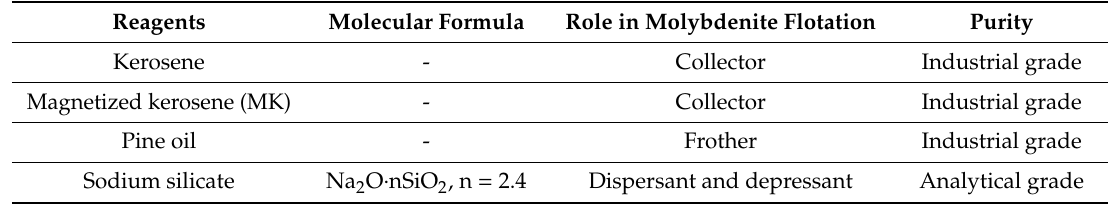
Table 3. Reagents used in the